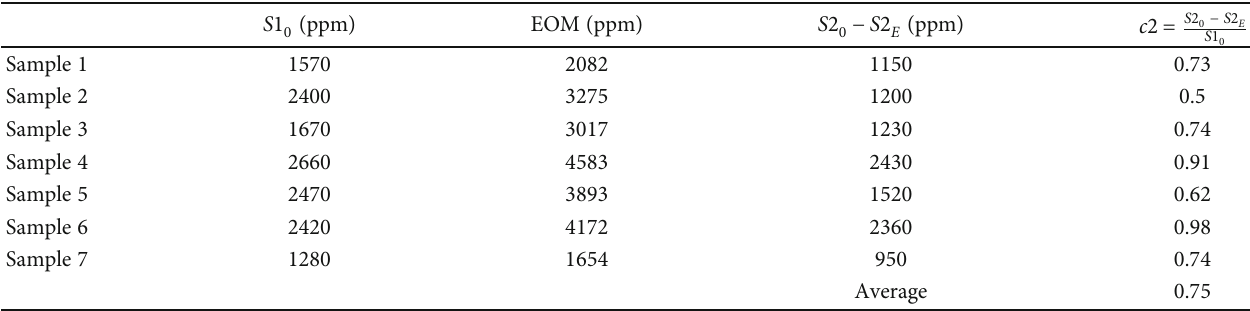
Table 2: Amount of hydrocarbons measured in a following laboratory procedures: (1) S 1 measurement carried out for a sample before bituminous extraction (ppm); (2) EOM — amount of hydrocarbons received in bituminous solvent extraction procedure (ppm); (3) S 2 0 − S 2 E = Δ S 2 — a di ff erence in S 2 values for Rock Eval measurements carried out before and